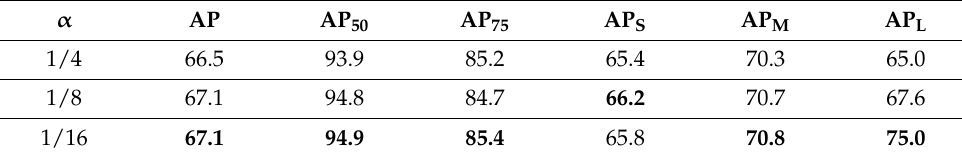
Table 7. Ablation experiment results of factor α on the SSDD dataset.